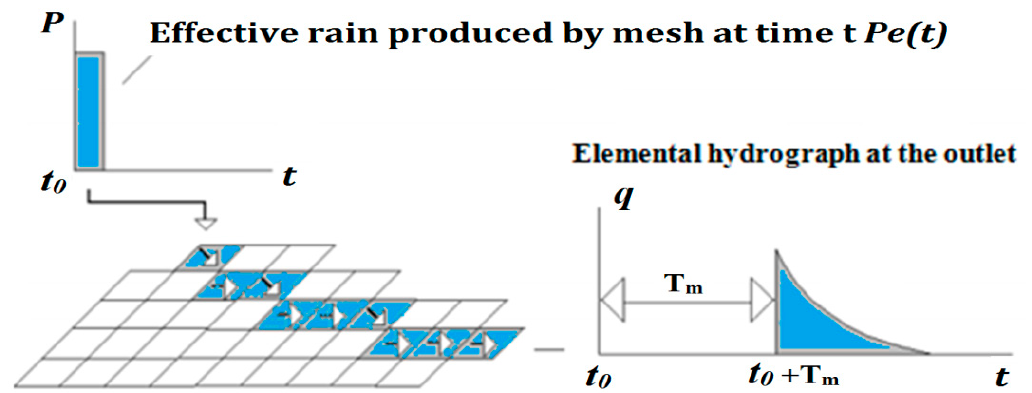
Figure 6. Routing model operating for each mesh of the basin (www.athys-soft.org, accessed on 15 March 2022).